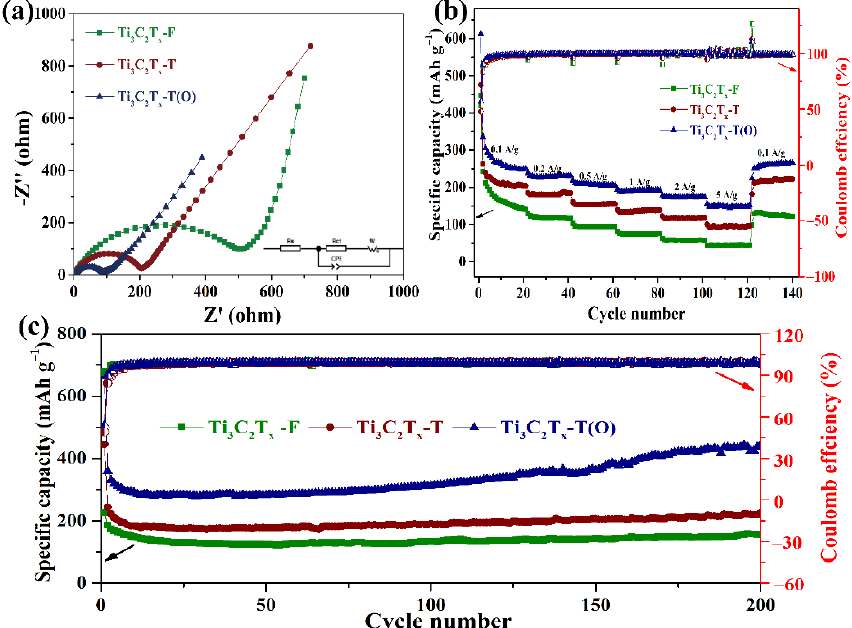
Figure 6. ( a ) Nyquist plots; ( b ) rate performance at different current densities; ( c ) cycling perfor- mance at 0.1 A g − 1 for different anodes of Ti 3 C 2 T x -F, Ti 3 C 2 T x -T and Ti 3 C 2 T x